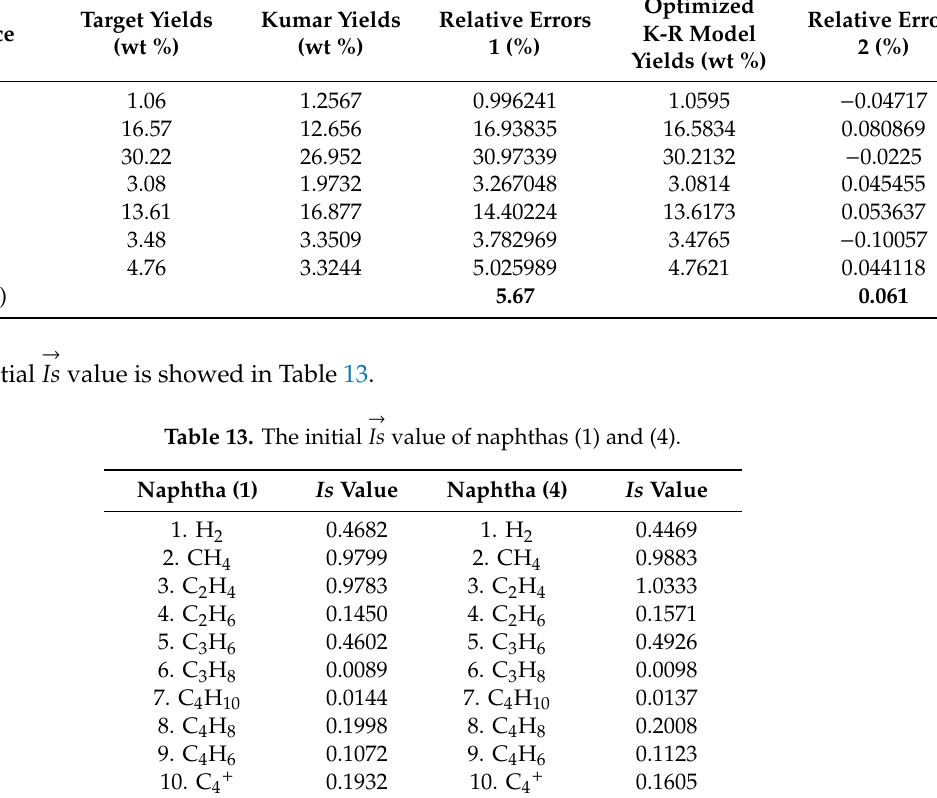
Table 12. The optimization result of naphtha (4).